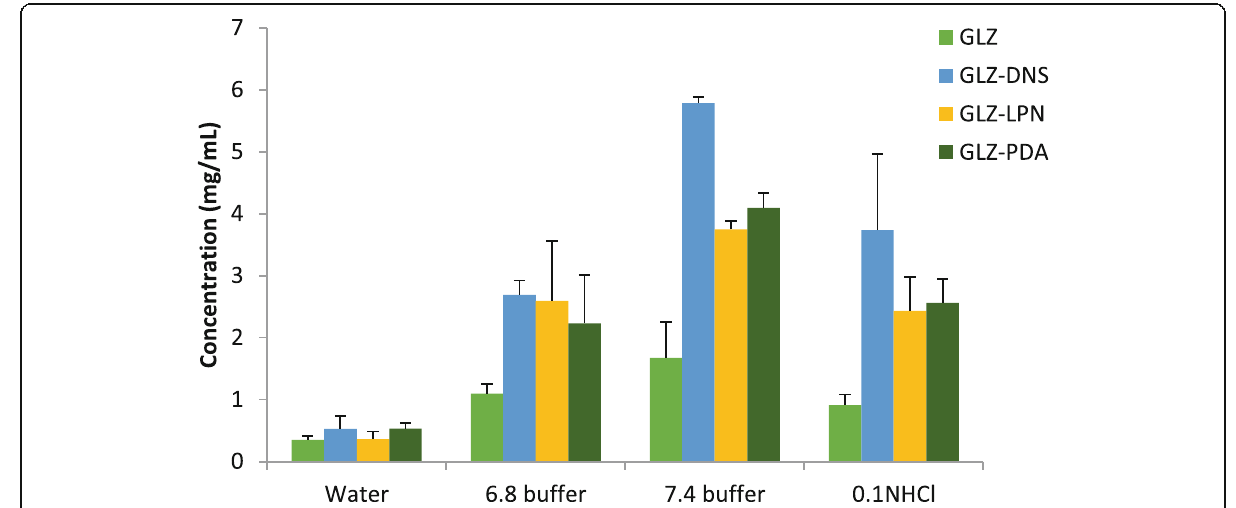
Fig. 7 Solubility analysis of GLZ, GLZ – DNS, GLZ – PDA, and GLZ – LPN cocrystals in different dissolution media